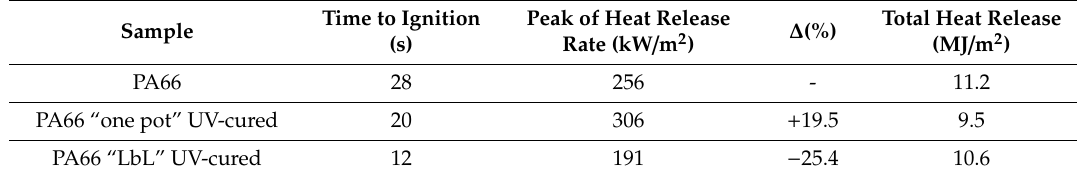
Table 2. Results from cone calorimetry tests .